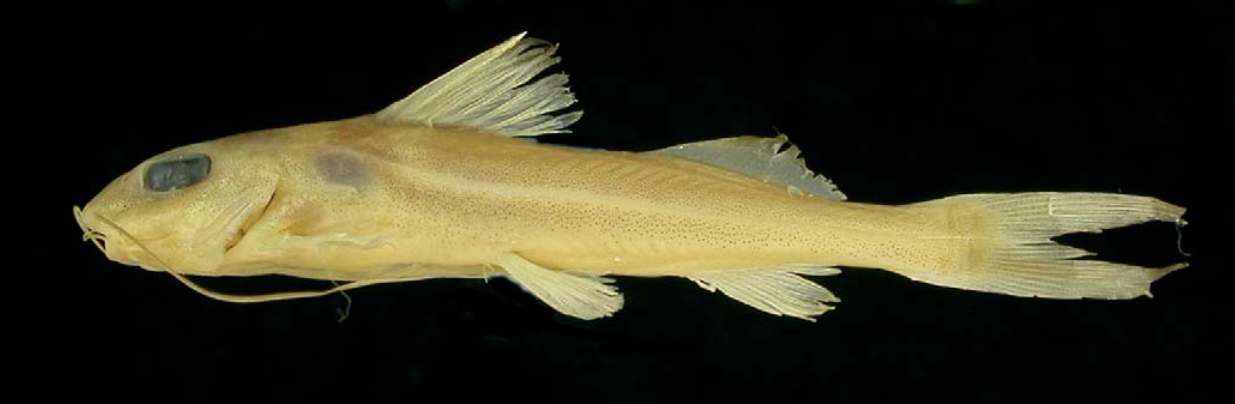
Fig. 1. Pimelodus stewarti , holotype, MCP 41737, 54.1 mm SL, rio Paranã, rio Tocantins drainage,